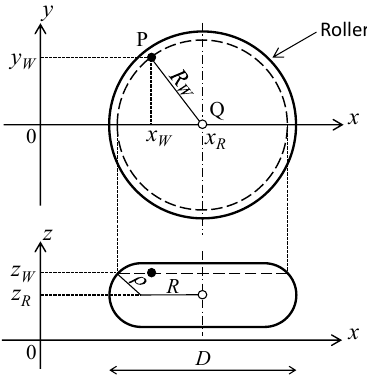
Figure 2. Position of the center of the roller, Q. Point P on the tube with the target shape is also on the surface of the roller.